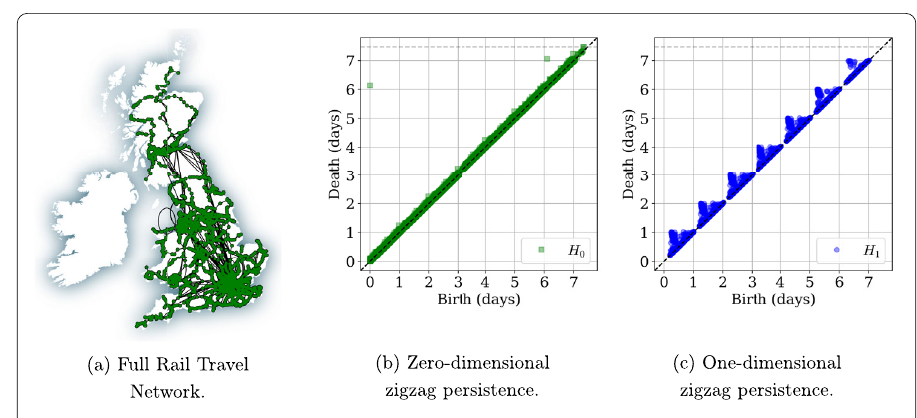
Figure 6 Zigzag persistence diagrams of the rail transportation network of Great